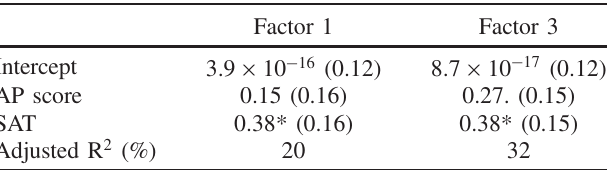
TABLE V. Multiple regression analysis of FMCE subscores on AP exam scores and SAT scores. (cid:2)(cid:2)(cid:2) p < 0 . 001 , (cid:2)(cid:2) p < 0 . 01 , (cid:2) p < 0 . 05 , . p < 0 . 1 .